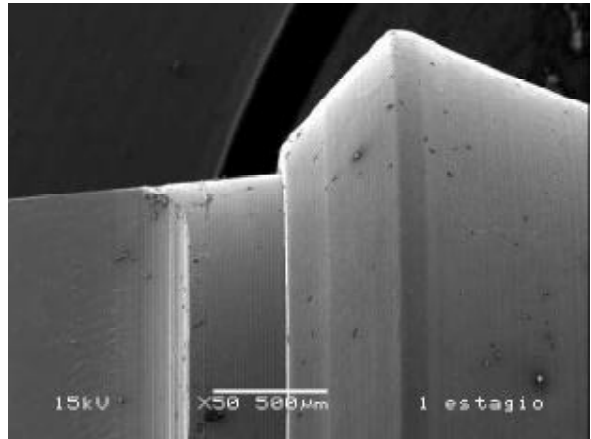
FIGURA 9- Localização da fenda no sistema de um estágio (seta). Observar a presença de dois planos (50xs)